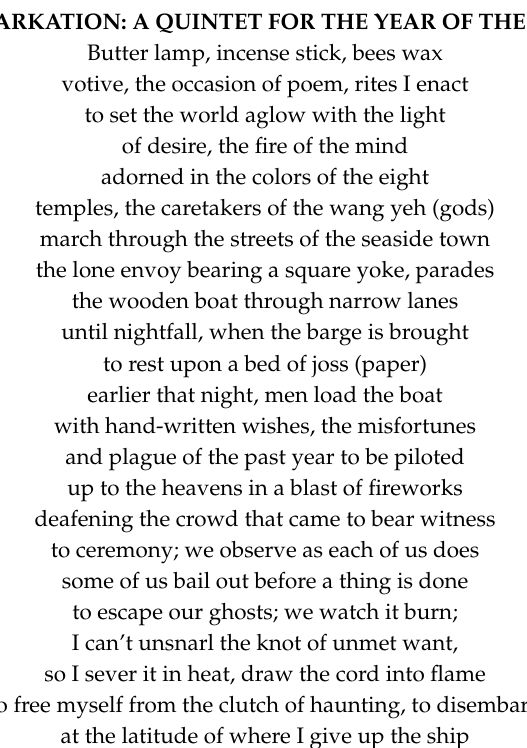
Figure 10. Incense burning during the Wang Yeh boat burning festival. Image courtesy of Ye Mimi.